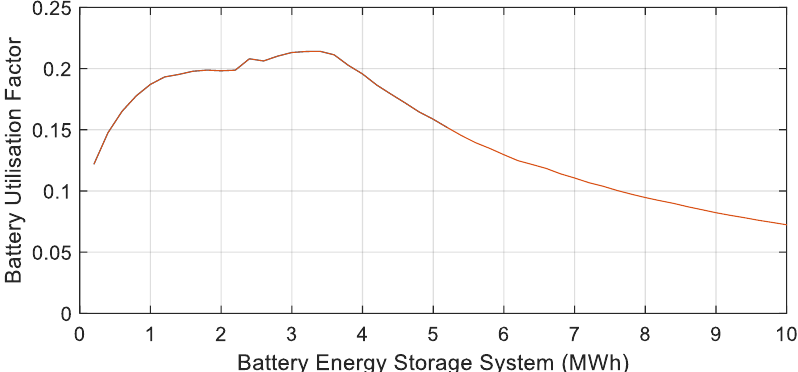
Figure 6. Battery utilization factor for different sizes of BESSs.